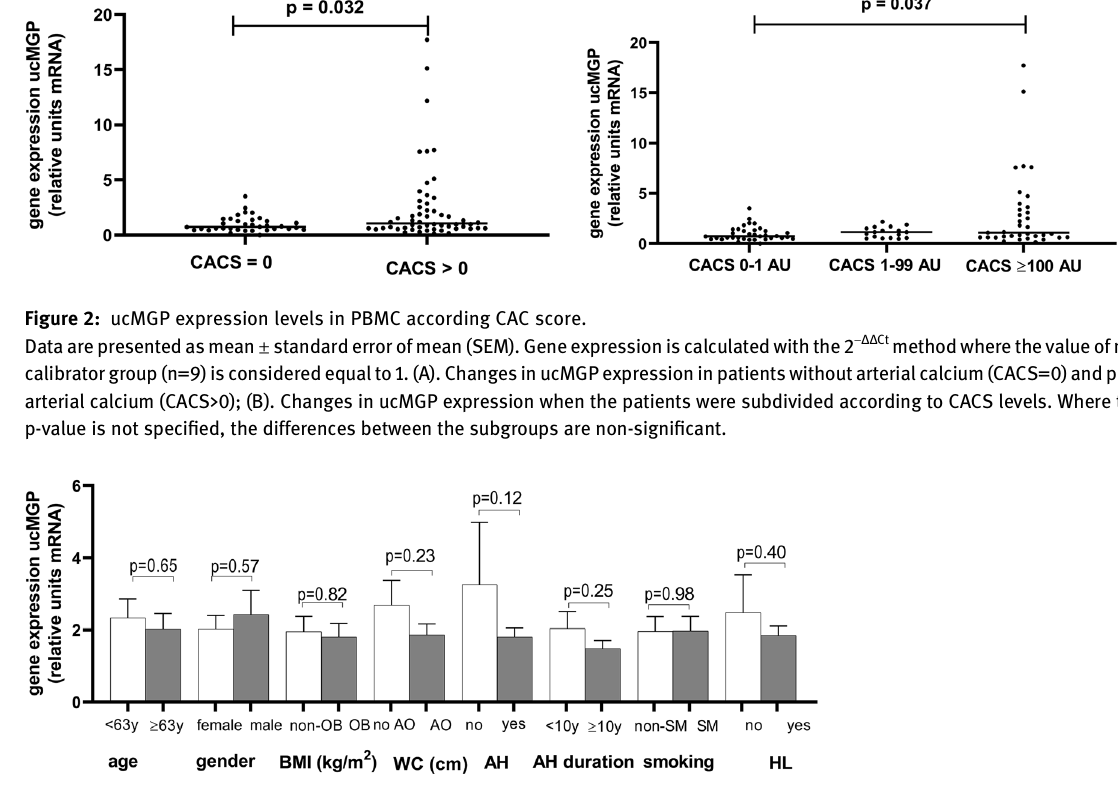
Figure 3: MGP expression levels in PBMC according to etiologic risk factors for CVD. Data are presented as mean ± standarderror of mean (SEM).Gene expression is calculatedwith the 2 − ΔΔ Ct methodwherethe value of mRNA in the calibratorgroup (n=9)is considered to be equalto 1.The median age of the studiedparticipants (63 years)is consideredas a cut-offvalue for subgroup analysis. Body mass index (BMI) is calculated and represented as kg/m 2 , where BMI<30 kg/m 2 were considered as non-obese (non-OB) and BMI ≥ 30 kg/m 2 as obese (OB). Waist circumference (WC) is measured in cm, where WC ≤ 88 cm for females and WC ≤ 102 cm for males is considered as no abdominal obesity (no AO) and WC>88 for females and WC>102 for males is considered as abdominal obesity (AO). AH, presence of arterial hypertension; HL, presence of hyperlipidemia; non-SM, non-smokers; SM, smokers. Where the p-value is not speci fi ed, the differences between the subgroups are non-signi fi cant.